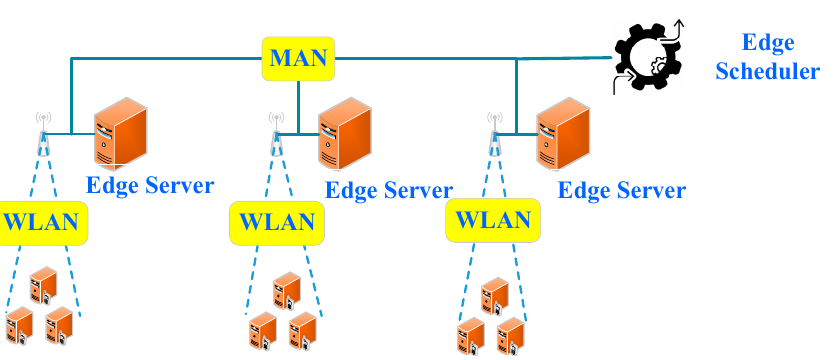
Figure 3. Scheduler-based edge computing.